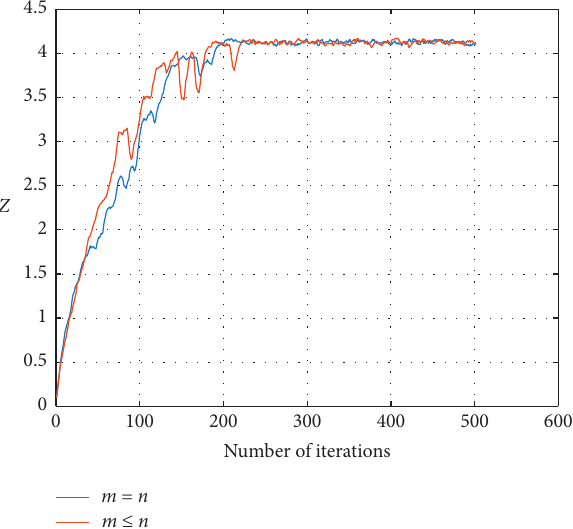
Figure 10: Influence of the number of the SAD on the overall satisfaction value Z .